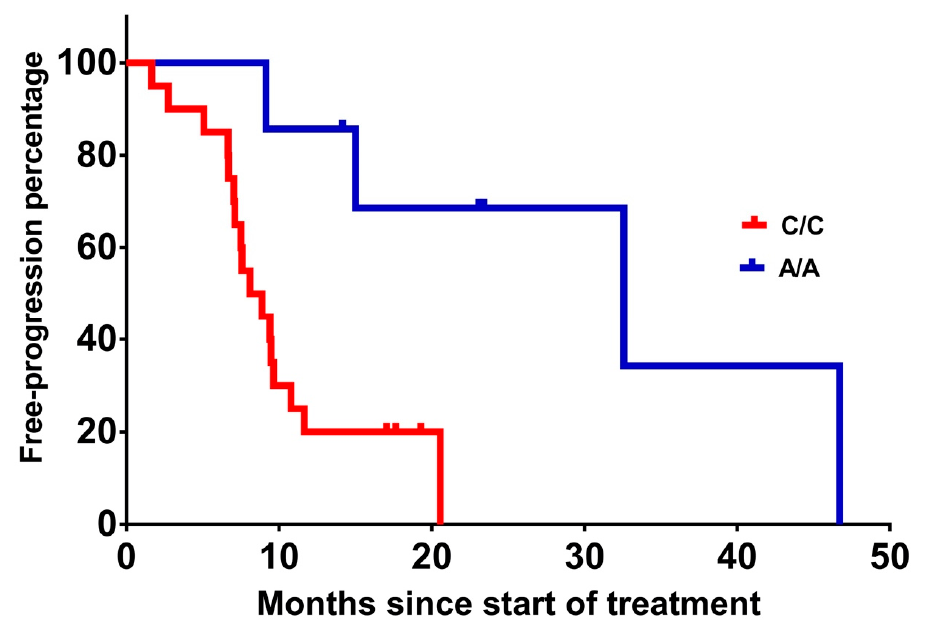
Figure 1. Progression-free survival (PFS) from the treatment initiation of patients with VEGF-A rs699947 A/A vs. C/C (31.1 vs. 10.1 months, p = 0.006). Table 3. Analysis of the polymorphisms for progression-free survival (PFS) and overall survival (OS).